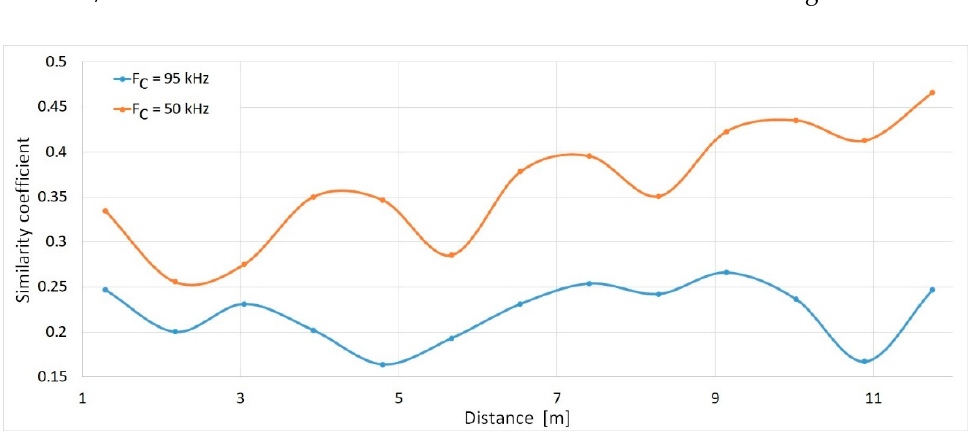
Figure 3. An example of the module of the estimate of impulse responses calculated in a simulation for chirp-up and chirp-down signals sent at the same time on the same center frequency in shallow water for a transmitter moving at a speed of 15 m/s.